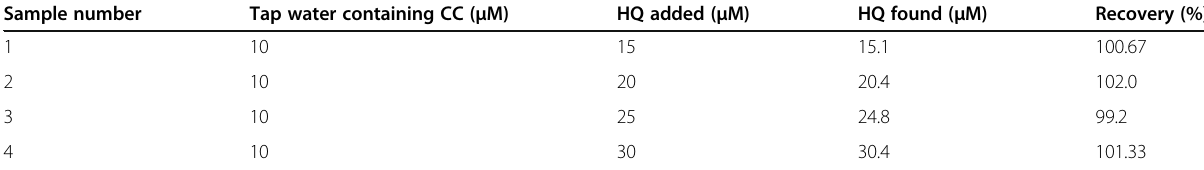
Table 4 Anti-interference results obtained for HQ in tap water sample containing CC at ALR/GCE ( n = 5) Sample